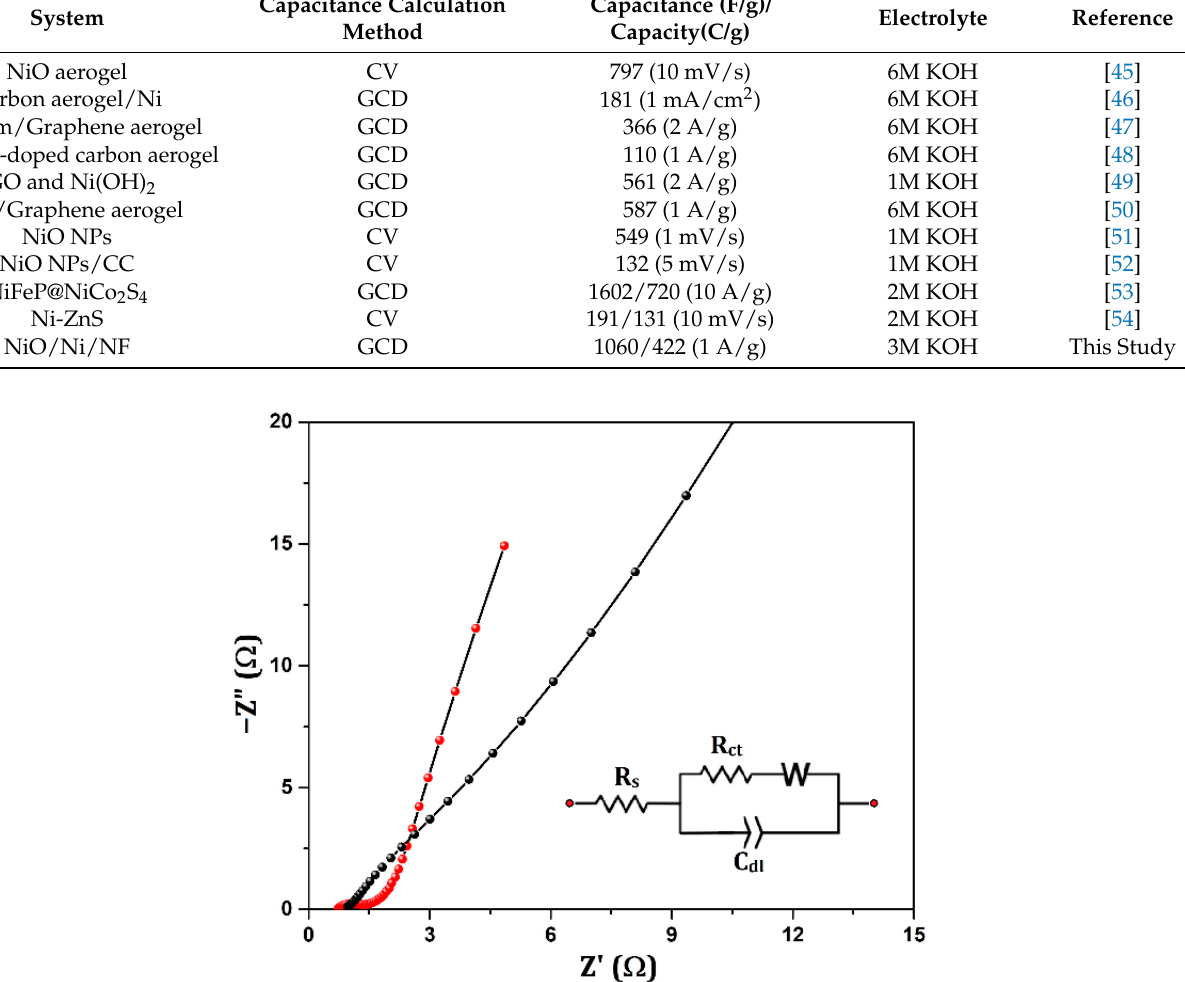
Table 2. The practical application of aerogel-based electrode materials and their performance com- parison.